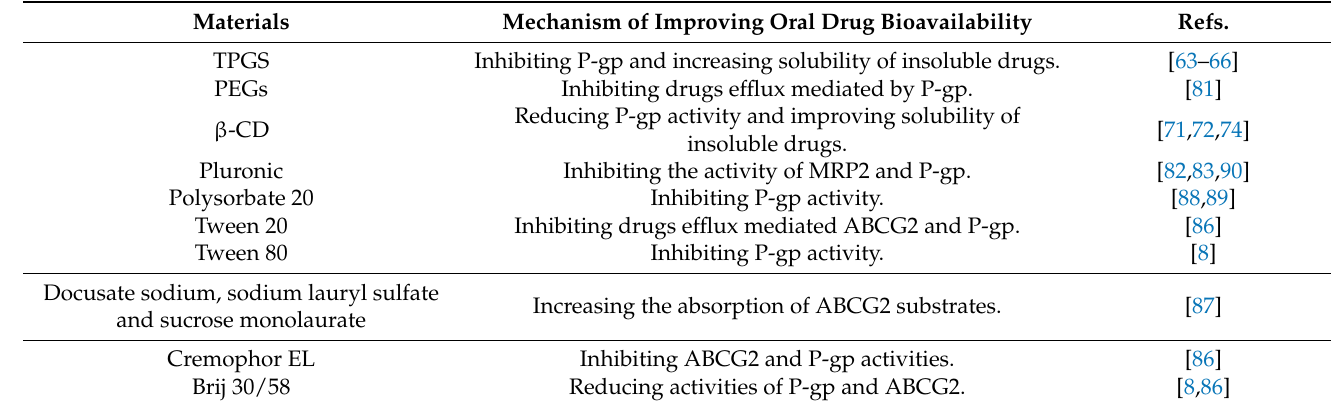
Table 2. Excipients to enhance oral drug